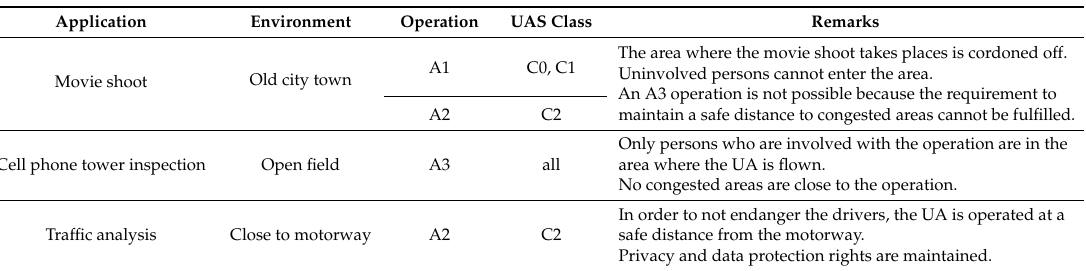
Table 7. Theoretical examples for UAS